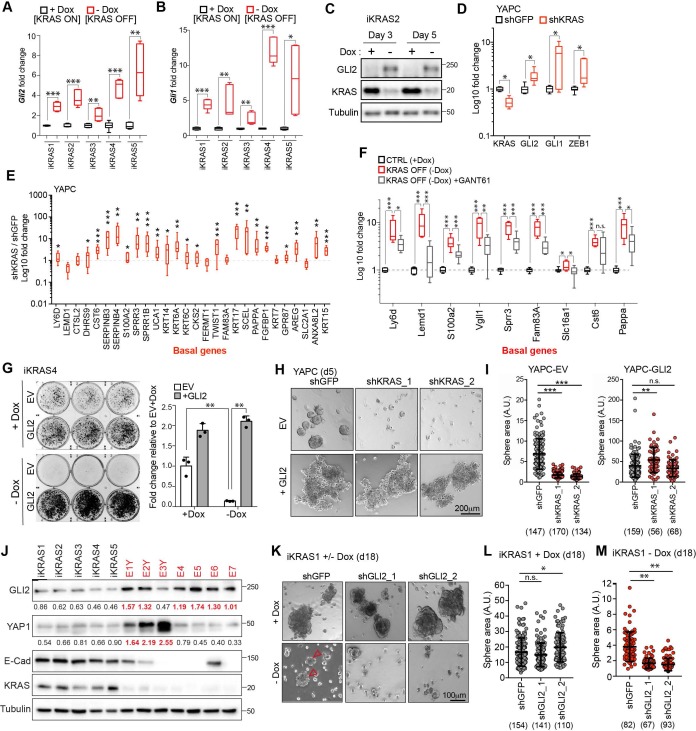
GLI2-mediated basal-like subtype switching rescues viability of PDA cells following KRASG12D ablation.(A,B) Effect of Dox depletion for 3 days on levels of Gli2 (A) and Gli1 (B) mRNA as measured by qRT-PCR in the indicated iKRAS cell lines, (n = 3). (C) Immunoblot shows expression of GLI2 and KRAS in iKRAS2 cells + Dox and – Dox for 3 and 5 days. (D,E) Effect of shRNA-mediated knockdown of KRAS on GLI2, GLI1, ZEB1 mRNA levels (D) and basal-like gene expression (E) as measured by qRT-PCR in YAPC cells. (n = 3). (F) Fold change in the basal-like gene signature in iKRAS4 cells following Dox removal (red plot) for 3 days or Dox removal in conjunction with 5 μM GANT61 treatment (grey plot). qRT-PCR measurement of the indicated genes in both conditions are normalized to the +Dox control condition (black plot) (n = 3). (G) Colony-forming ability of iKRAS4 cells stably expressing empty vector (EV) or Flag-tagged mGLI2 (GLI2) grown in the presence (top) or absence (bottom) of Dox for 6 days, followed by staining with crystal violet. Graph shows the fold change in growth relative to the EV +Dox setting. Results shown are representative of n = 3 experiments. (H,I) Images (H) show the effect of stable expression of EV (top) or Flag tagged GLI2 (bottom) on YAPC sphere formation 5 days post shRNA-mediated knockdown of KRAS compared to control cells (shGFP). Quantification of sphere area for each condition is shown (I). Number of spheres measured per condition is indicated in parenthesis. Scale bar, 200 μm. (J) Immunoblots show expression of the indicated proteins in iKRAS (black) and Escaper (red) cell lines. Numerical values indicate levels of GLI2 and YAP1 normalized to Tubulin. Escaper cell lines denoted with ‘Y’ harbor genomic amplification of Yap1. (K–M) Images (K) show the effect of shRNA-mediated knockdown of Gli2 using two separate hairpins on iKRAS1 sphere formation when grown in the presence (top) or absence (bottom) of Dox for 18 days. Quantification of sphere area in the presence (L) and absence (M) of Dox is shown. Number of spheres measured per condition is indicated in parenthesis. Arrowheads indicate growth of KRASG12D independent spheroids. Scale bar, 100 μm. p-Values were calculated by two-tailed unpaired t test. n.s. = not significant, *p<0.05; **p<0.01; ***p<0.001.10.7554/eLife.45313.017Figure 5—source data 1.GLI2-mediated basal-like subtype switching in response to KRASG12D ablation.